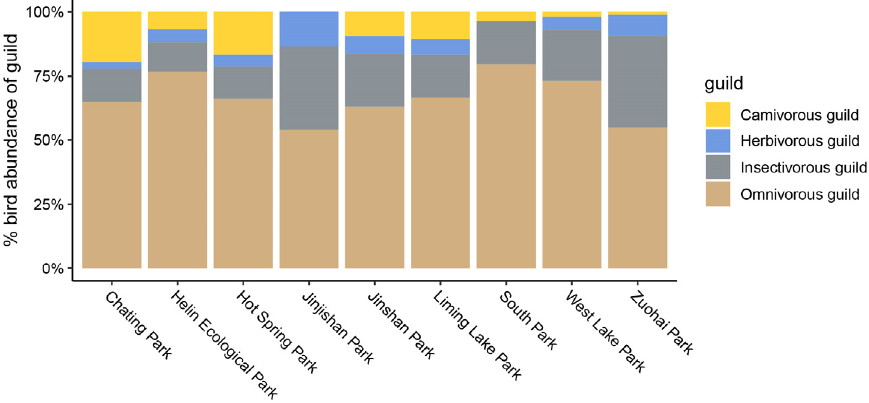
Figure 4. The percent-stacked bar plot represents the occurrence of the bird feeding guild abundance of 9 urban parks.